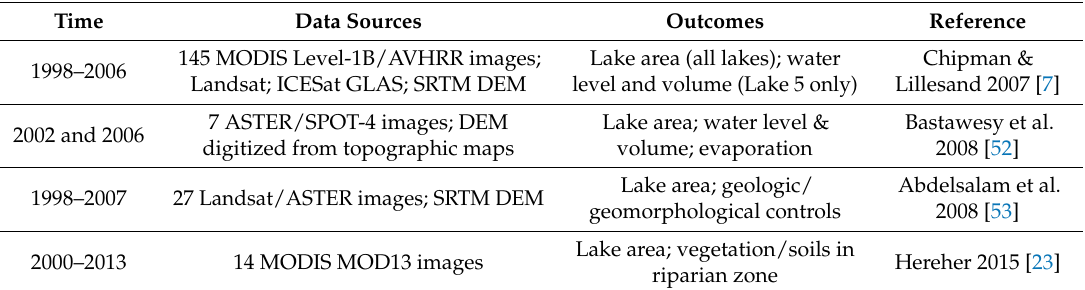
Table 1. Prior remote sensing studies of the hydrology of the Toshka